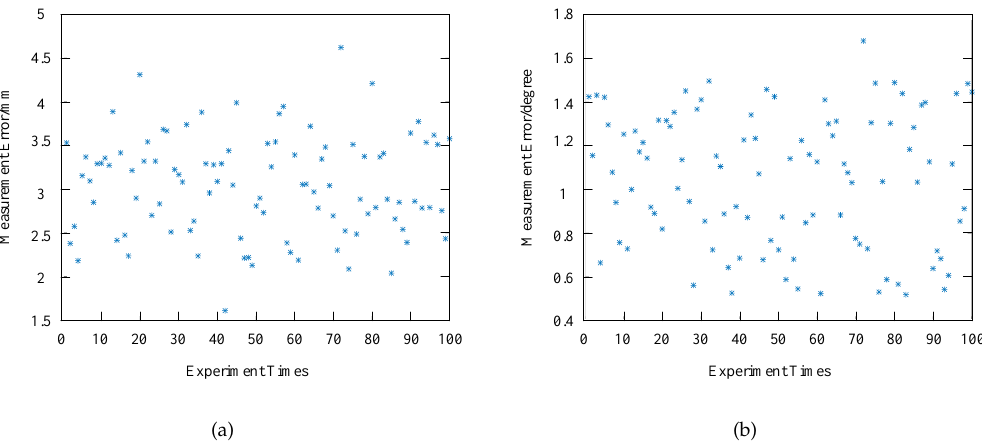
Figure 18. Measurement error in the experiment: ( a ) Measurement error of distance, ( b ) Measurement error of rotation